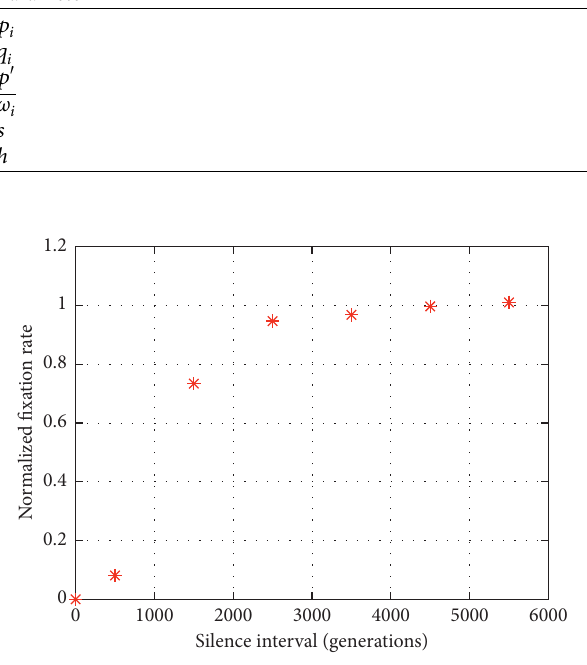
Figure 2: The relationship between the normalized fixation rate of allele and the duration of its silence interval in case of a fully the A 1 synchronous activation.